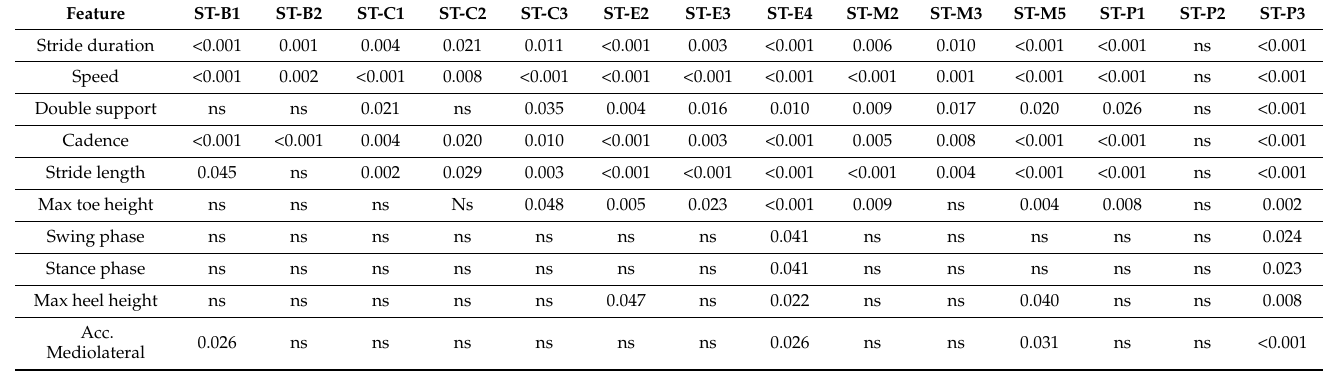
Table 5. Results of applying the t -test of each dual-tasking task vs. single-task gait for each normalized gait parameter.